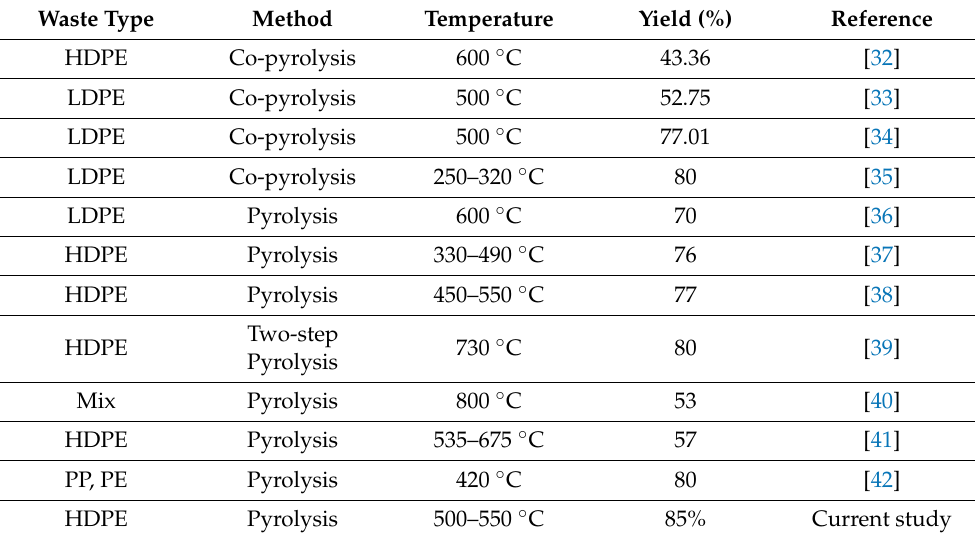
Table 7. Comparison of the percentage yield of liquid fuel from different types of plastic at different